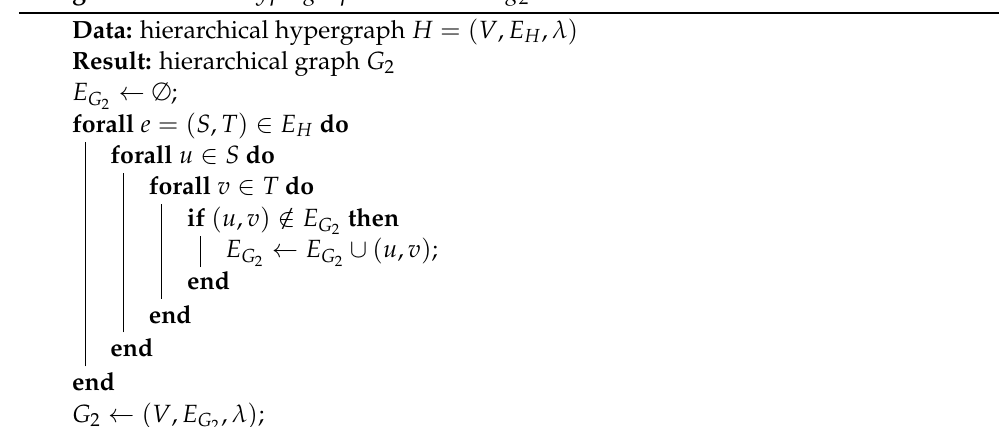
Figure 11. An example of a hypergraph transformation: ( a ) original hypergraph H ; ( b ) restructuring a hypergraph into a directed graph with balancing vertices; ( c ) restructuring a hypergraph into a directed graph. Algorithm 3: The hypergraphRestructuring 2